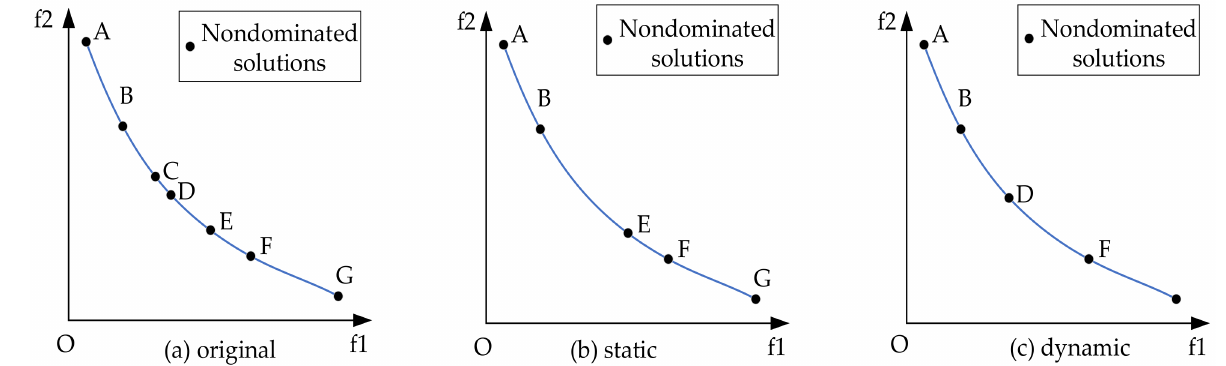
Figure 1. Comparison of static and dynamic archive maintaining. ( a ) A given set of non-dominated solutions; ( b ) The result of static archive maintaining; ( c ) The result of dynamic archive maintaining.